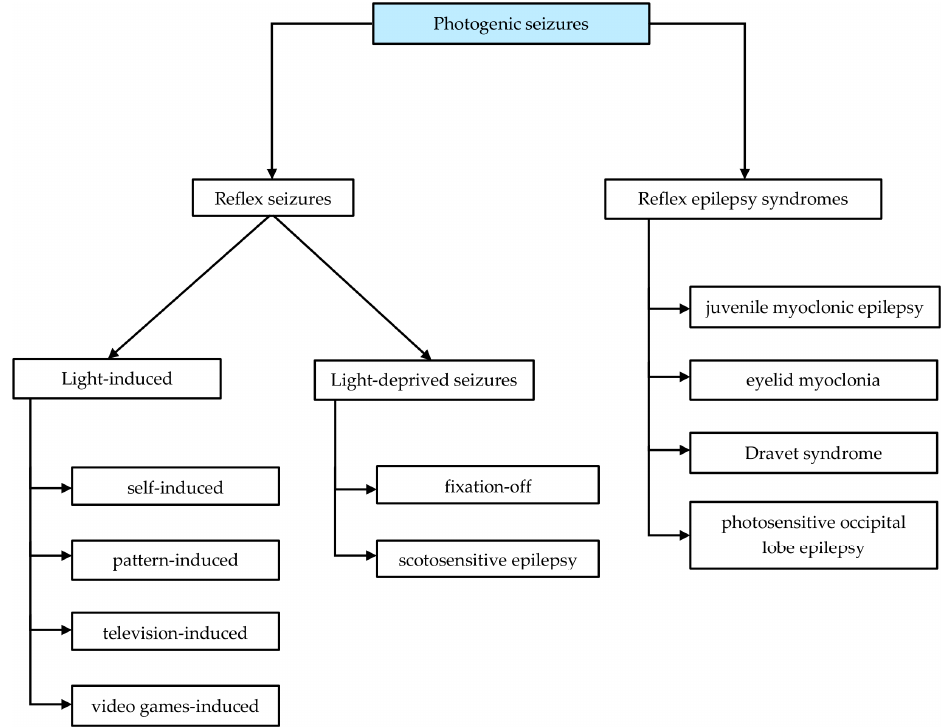
Figure 2. Classification of photodependent seizures.